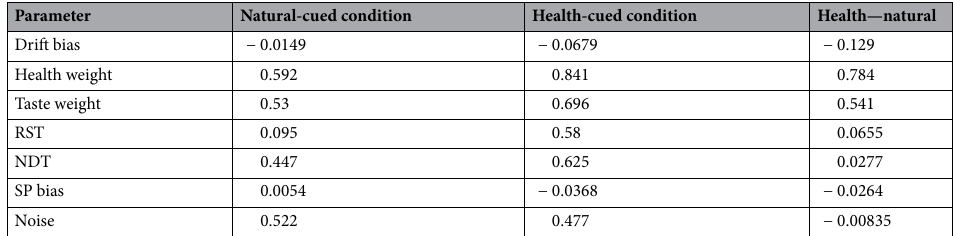
Table 2. Intra-class correlation coefficients (ICC). ICC of rstDDM parameters over 5 sessions for both conditions of natural-cued and health-cued and also for the difference between these two conditions. NDT non-decision